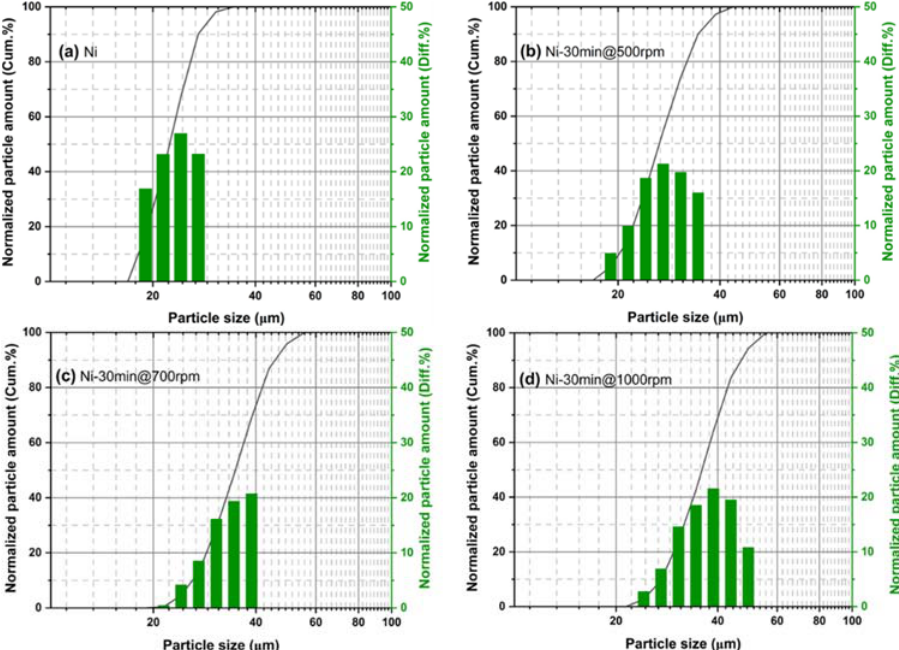
Figure 3. The particle size distribution of ( a ) pristine Ni powder and as ‐ milled Ni powder for 30 min at ( b ) 500 rpm, ( c ) 700 rpm, and ( d ) 1000 rpm.